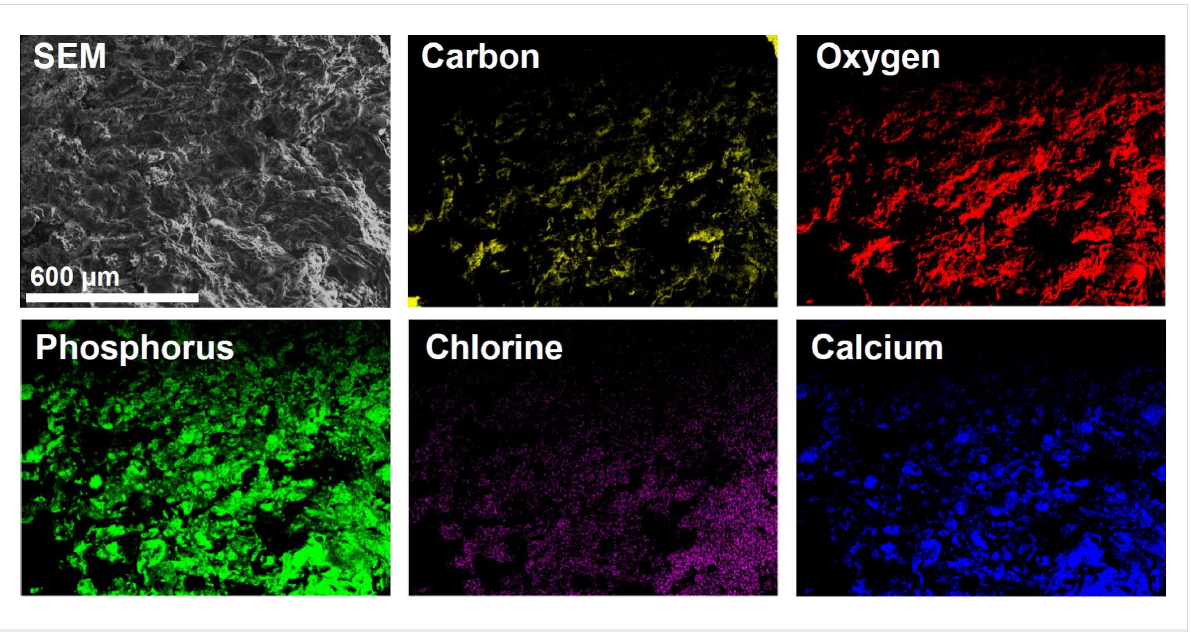
Figure 7: SEM image and elemental map of CCPH6.